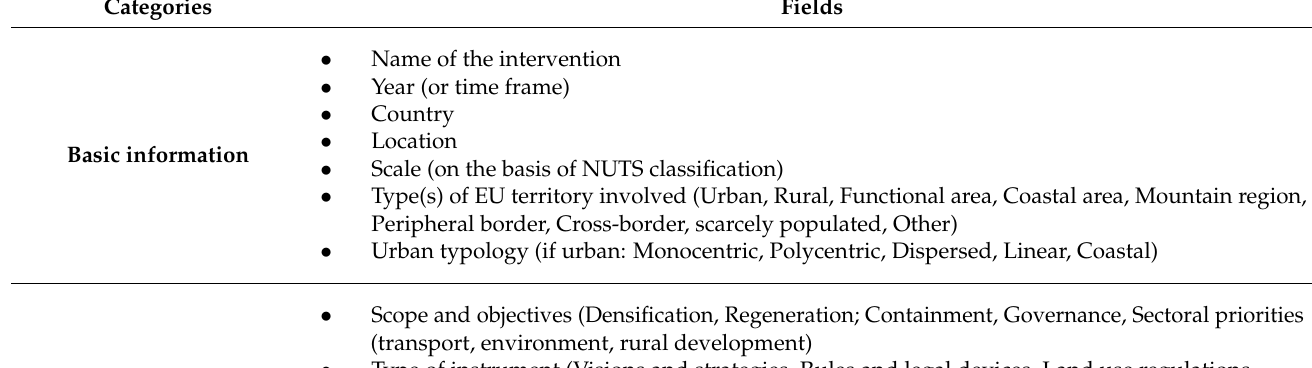
Table 2. Fields adopted in the analysis of the interventions (source: author’s own elaboration on the basis of [31] (p. 4)).